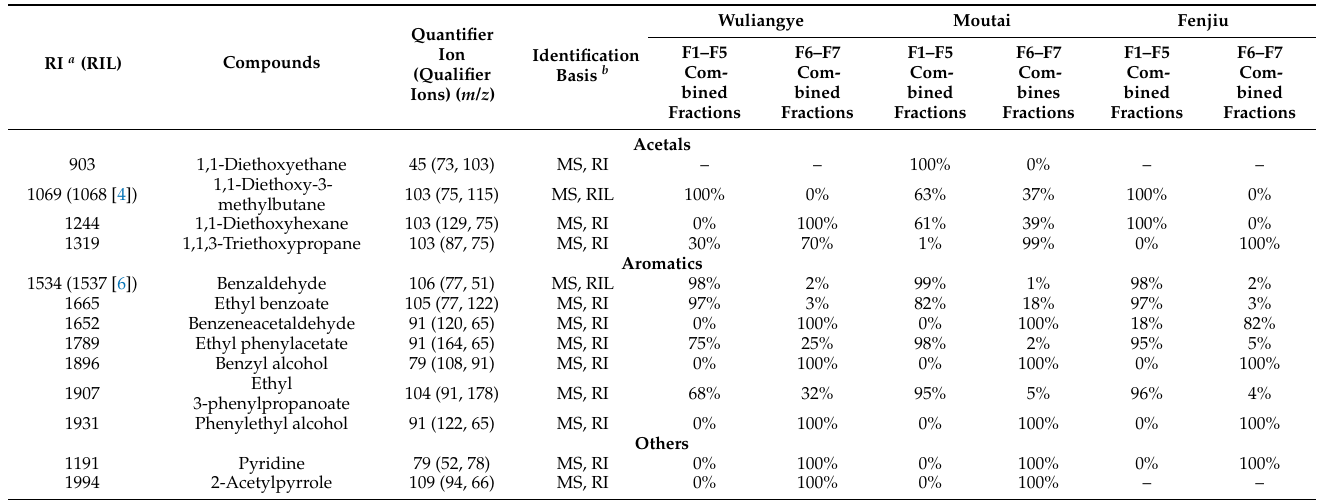
Figure 1. GC chromatogram of F7 (dichloromethane 90%:methanol 10%) of different baijiu samples: (a) Wuliangye; (b) Moutai; (c) Fengjiu. Note: (1) 2-pentanone; (2) 2-butanol; (3) 1-propanol; (4) 2-methyl-1-propanol; (5) 3-methyl-2-butanol; (6) 1-butanol; (7) 3-penten-2-ol; (8) 3-methyl-1-butanol; (9) 2-hexanol; (10) 1-pentanol; (11) 2-methylpyrazine; (12) acetoin; (13) 1,1,3-triethoxypropane; (14) 2-heptanol; (15) 2,6-dimethylpyrazine; (16) ethyl lactate; 17) 1-hexanol; ((18) 2-ethyl-6- methylpyrazine; (19) 3-octanol; (20) nonanal; (21) trimethylpyrazine; (22) ethyl 2-hydroxy-3-methylbutanoate; (23) 1-hep- tanol; (24) acetic acid; (25) furfural; (26) tetramethylpyrazine; (27) 2-ethyl-1-hexanol; (28) 2-acetylfuran; (29) ethyl 2-hy- droxy-4-methylpentanoate; (30) 1-octanol; (31) isoamyl lactate; (32) 2-methylpropanoic acid; 33) 1,2-propanediol; 34) ethyl 4-oxovalerate; 35) 2-acetyl-5-methylfuran; 36) butanoic acid; 37) 3-furanmethanol; (38) 3-methylbutanoic acid; (39) diehtyl butanedioate; (40) pentanoic acid; (41) ethyl phenylacetate; (42) 4-methylpentanoic acid; (43) hexanoic acid; (44) benzyl alcohol; (45) phenylethyl alcohol; (46) heptanoic acid; (47) phenol; (48) octanoic acid; (49) p-cresol; (50) nonanoic acid; (51) 2-ethylphenol.